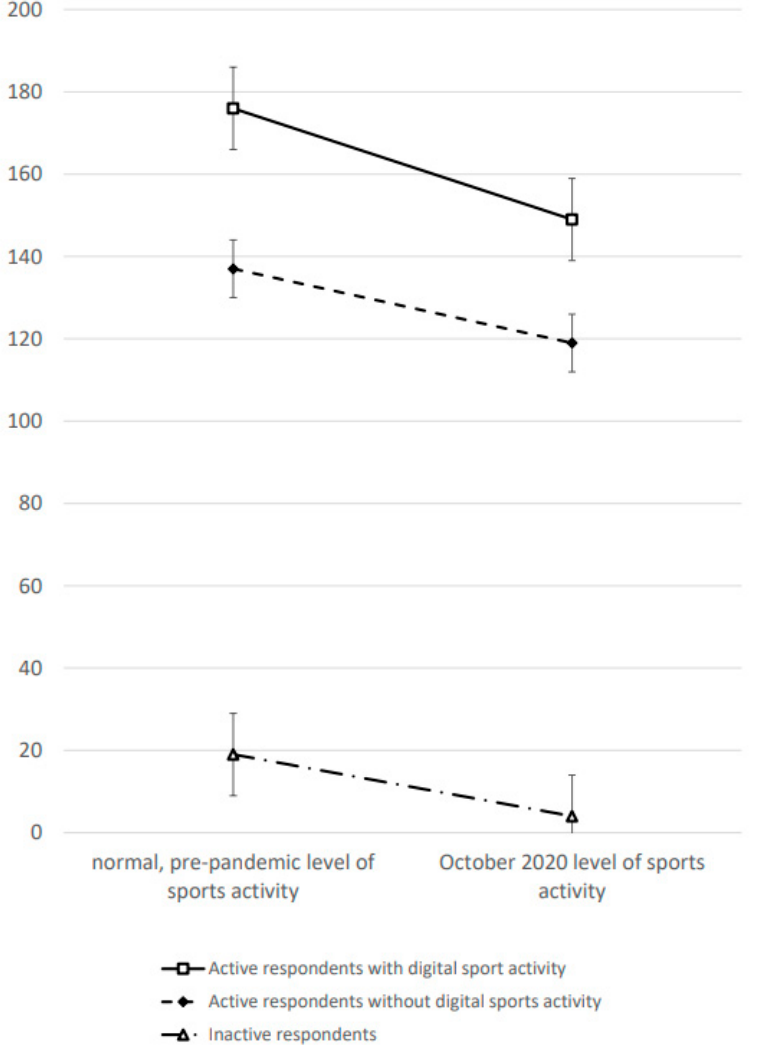
Figure 1. Level of sports activity (min/week) in the pre-pandemic period and in October 2020. Note: SPOVID Study. Estimated marginal means based on Generalized Linear Models. Error bars show the standard error of the mean. Differences in activity levels between active respondents with digital sport activity and active respondents without a digital sport activity are significant with p < 0.001. The time-group interaction is insignificant ( p = 0.504).